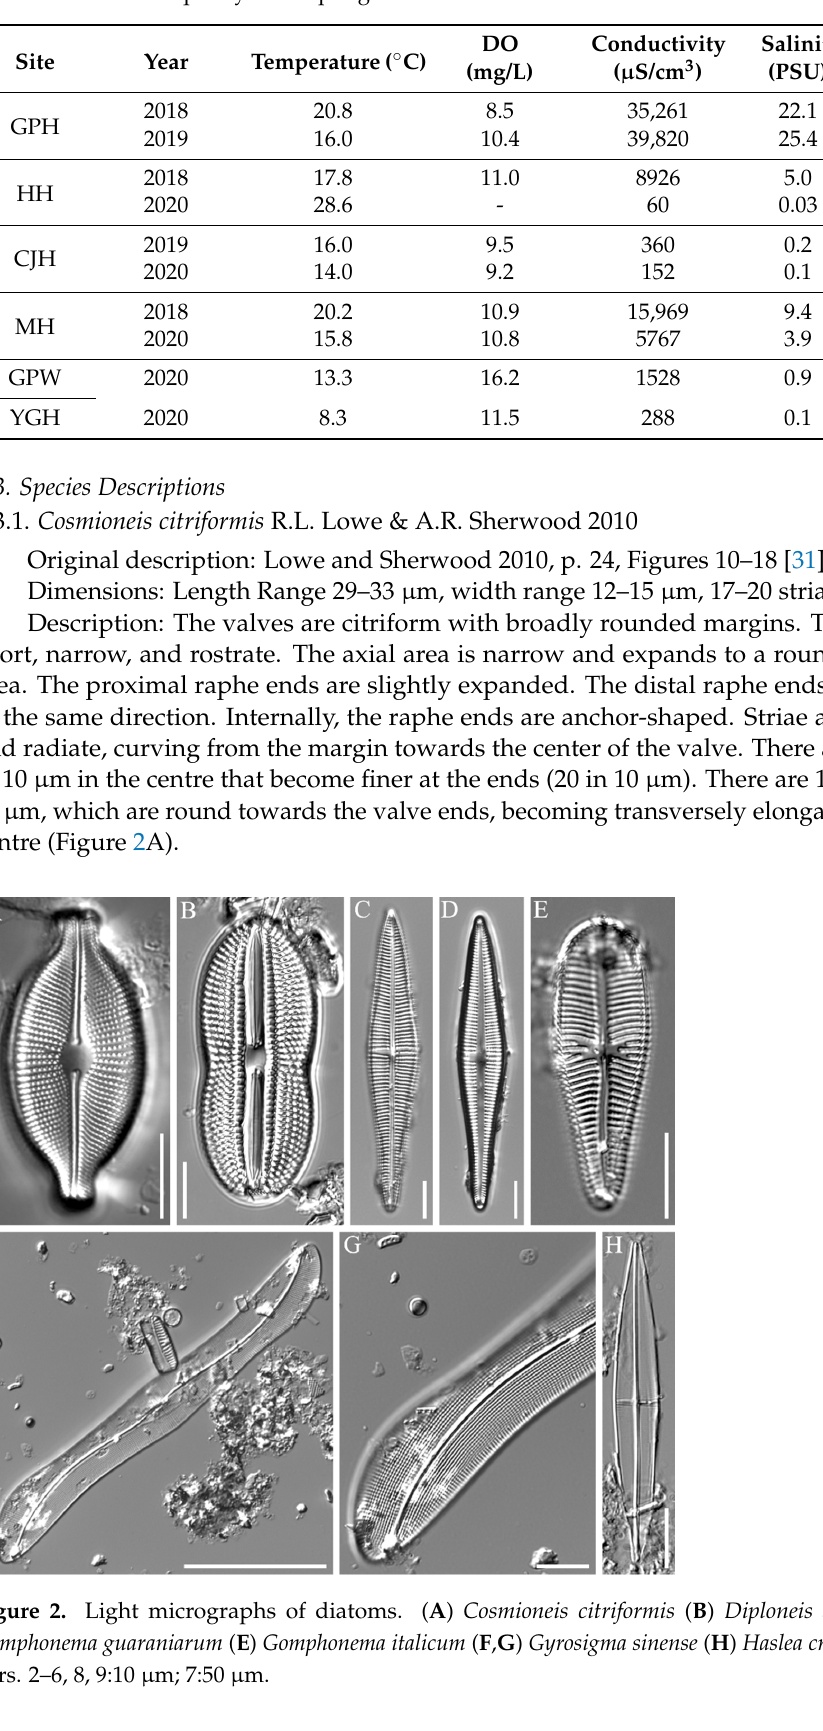
Table 2. Field water quality of sampling sites.